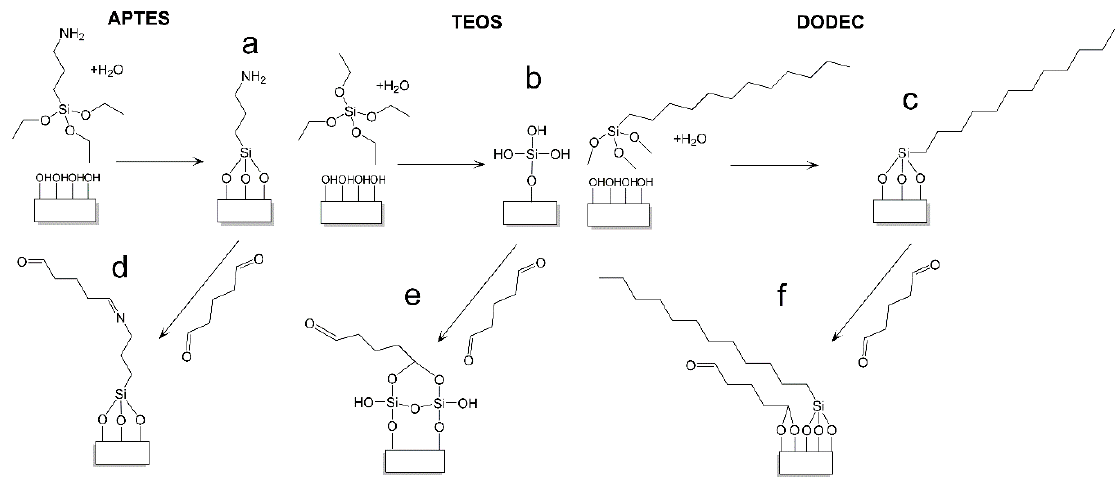
Figure 3. Proposed functionalization mechanism for each type of silane. ( a ) APTES, ( b )TEOS, ( c ) DODEC, ( d ) APTES + glu, ( e ) TEOS + glu and ( f ) DODEC + glu .